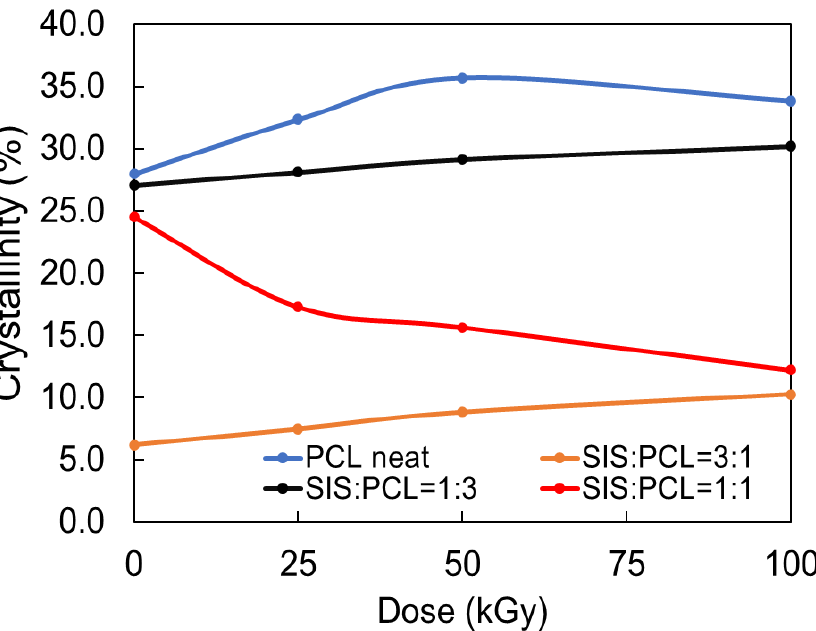
Figure 9. Variation of PCL crystallinity with both SIS concentration and irradiation dose. Table 2. DSC parameters obtained from DSC curves analysis.